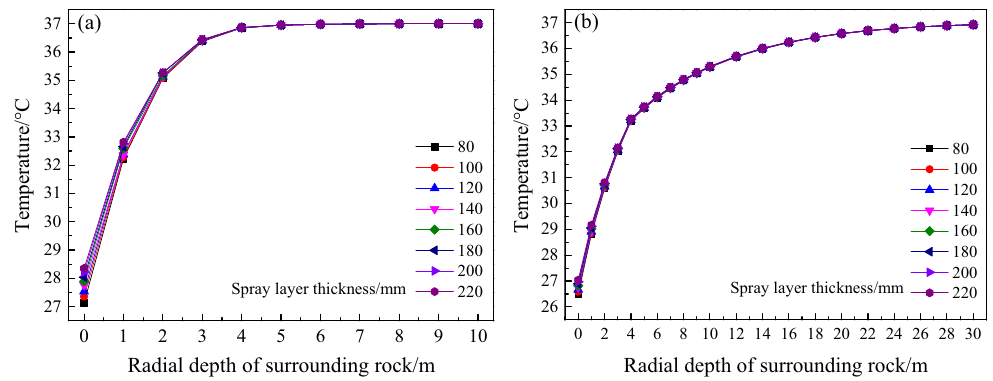
Figure 19: Influence of spray layer thickness on surrounding rock temperature field: ( a ) 30 days; ( b ) 1,095 days.